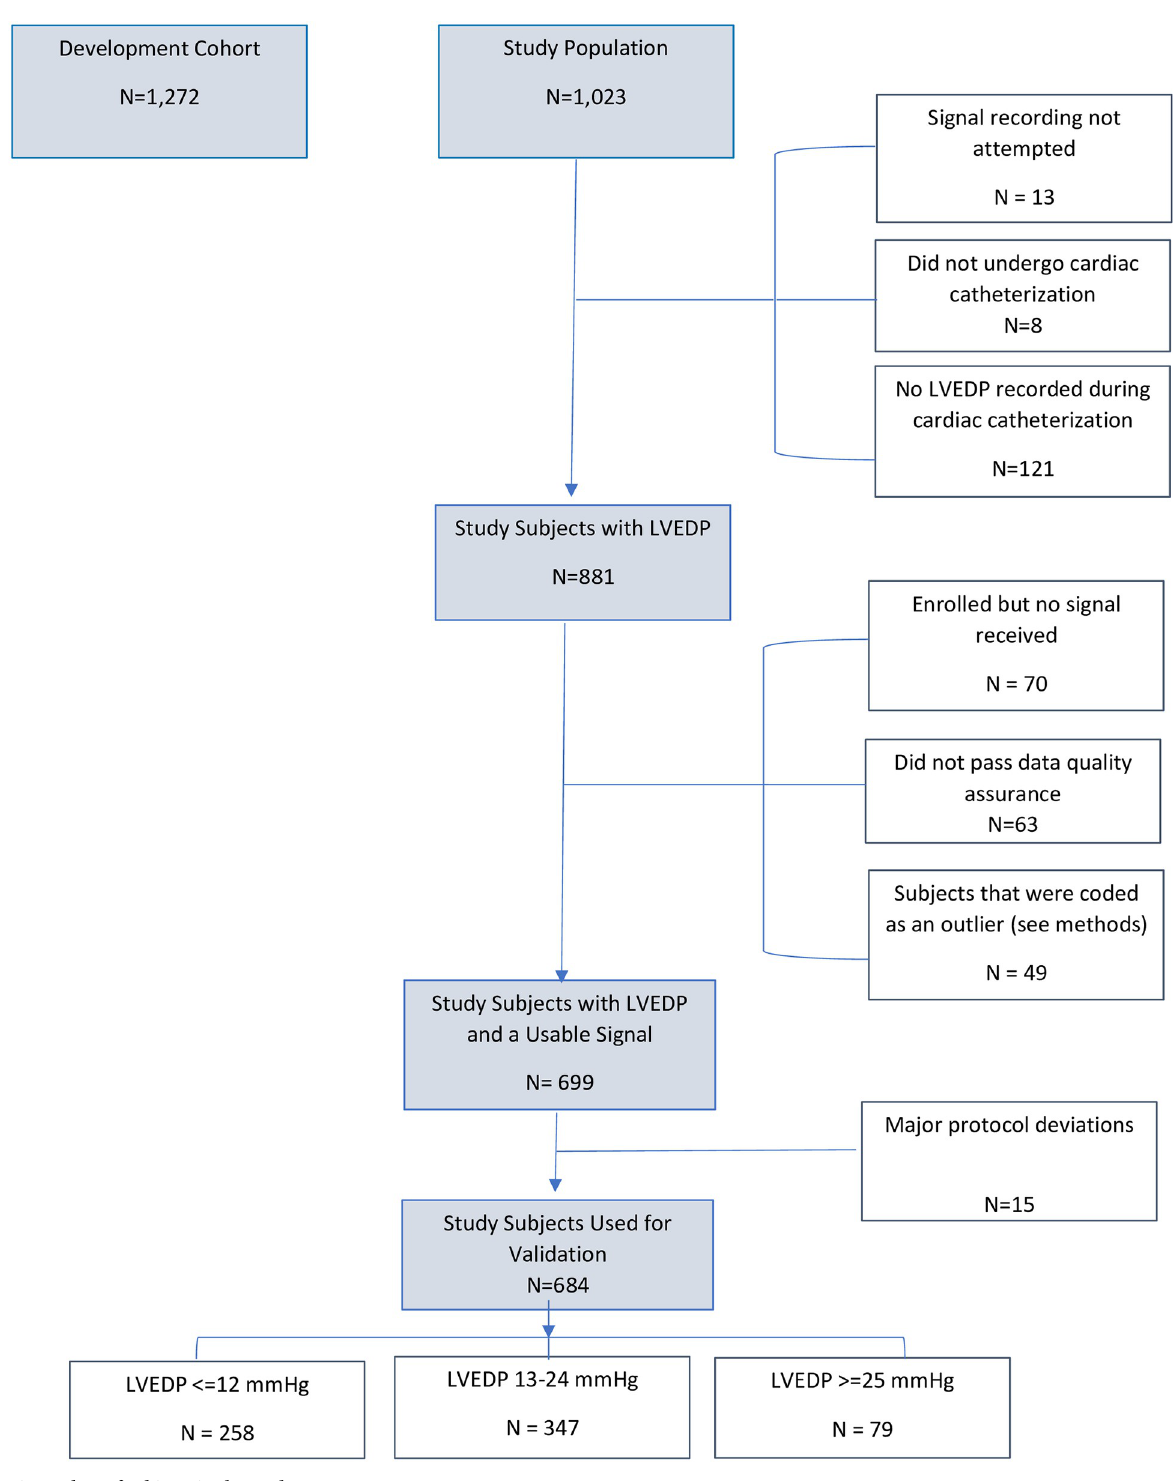
Fig 1. Flow of subjects in the study.